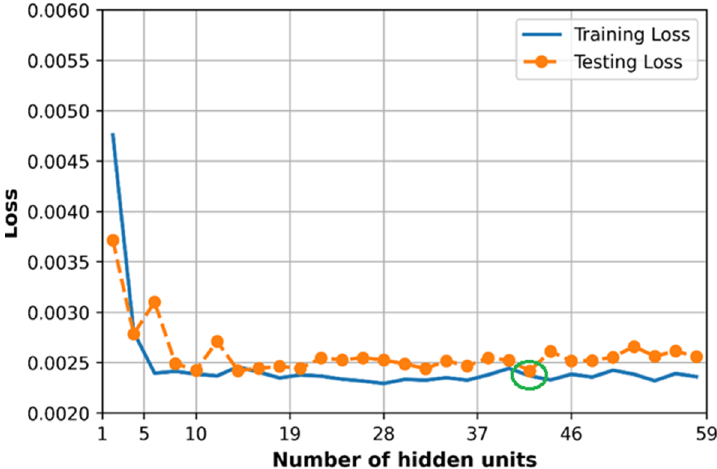
Figure 21. Comparison of loss with different the number of hidden units.